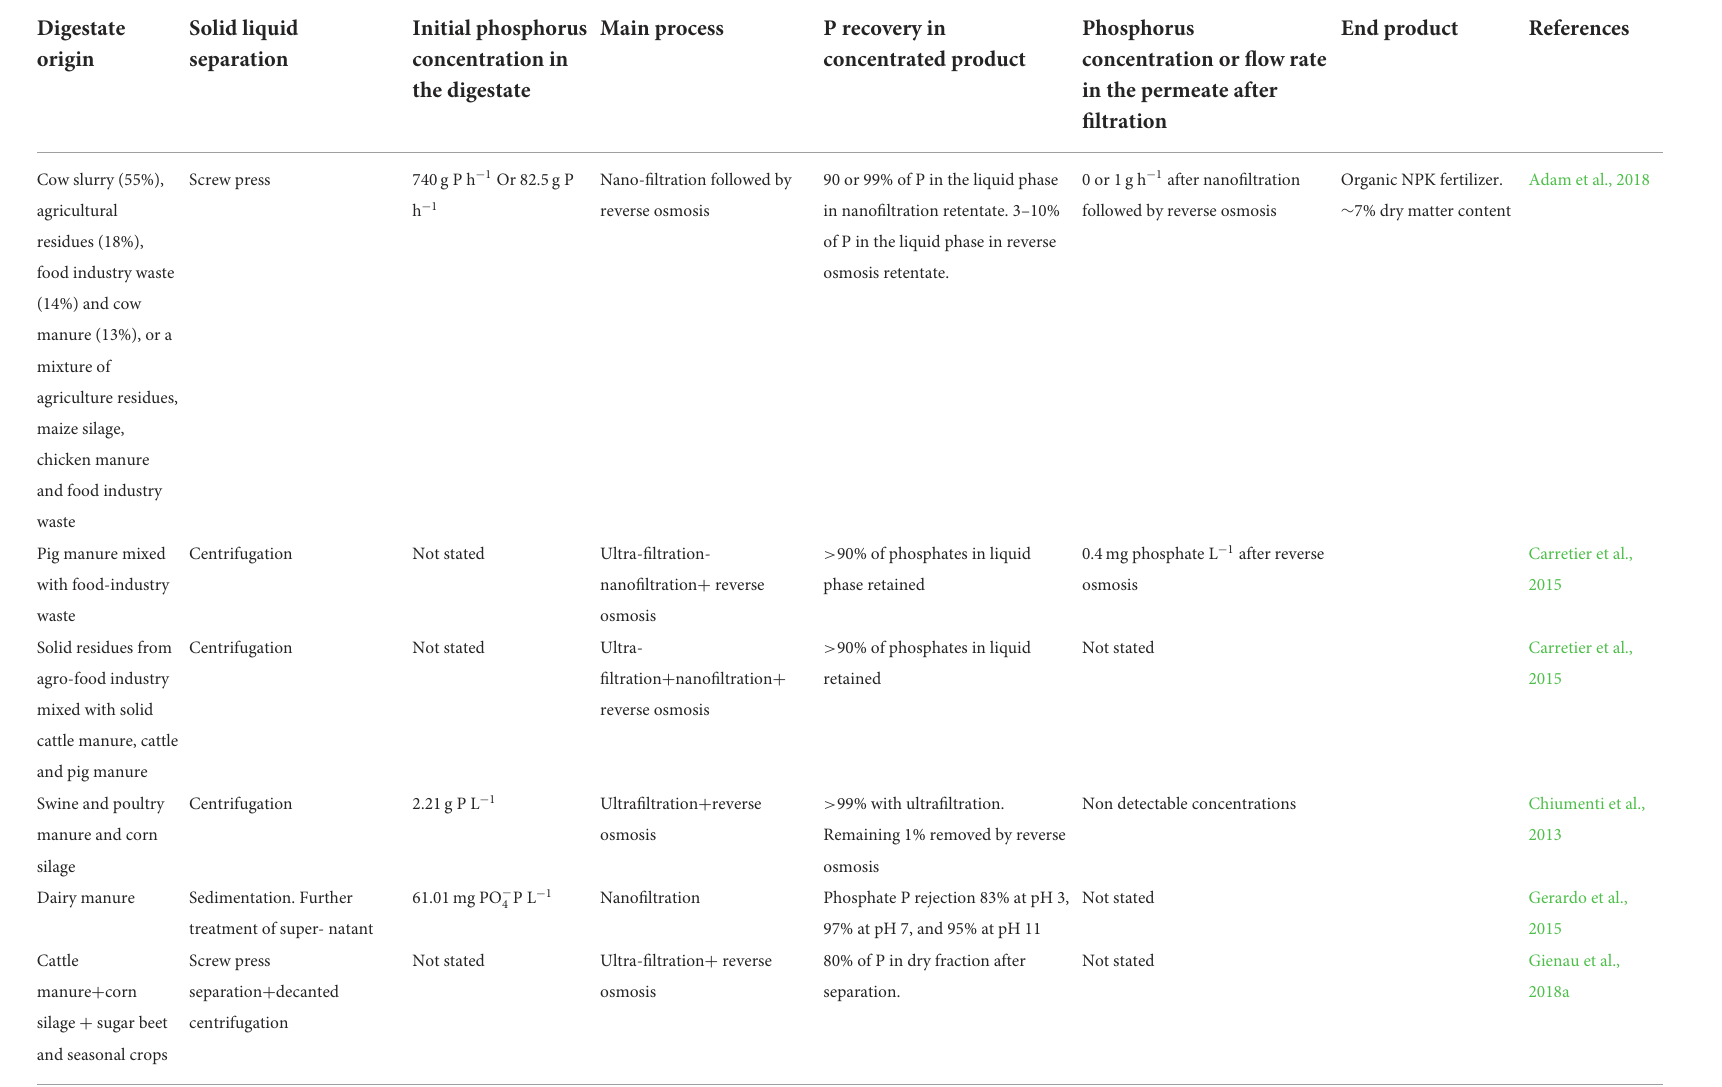
TABLE 2 Phosphorus (P) retention in experiments with membrane filtration of manure-based